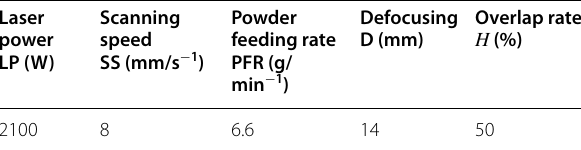
Table 4 Parameters of experiments Laser